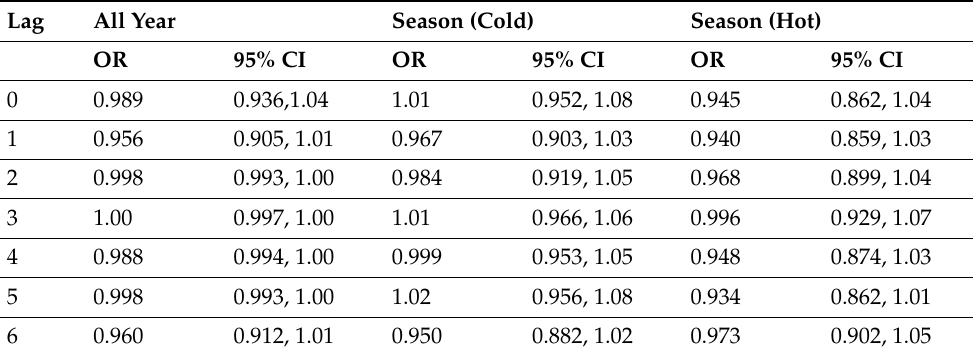
Table 5. Association of 24 h air pollution concentration of PM 2.5 and hospital admission for patients with ischemic heart disease.